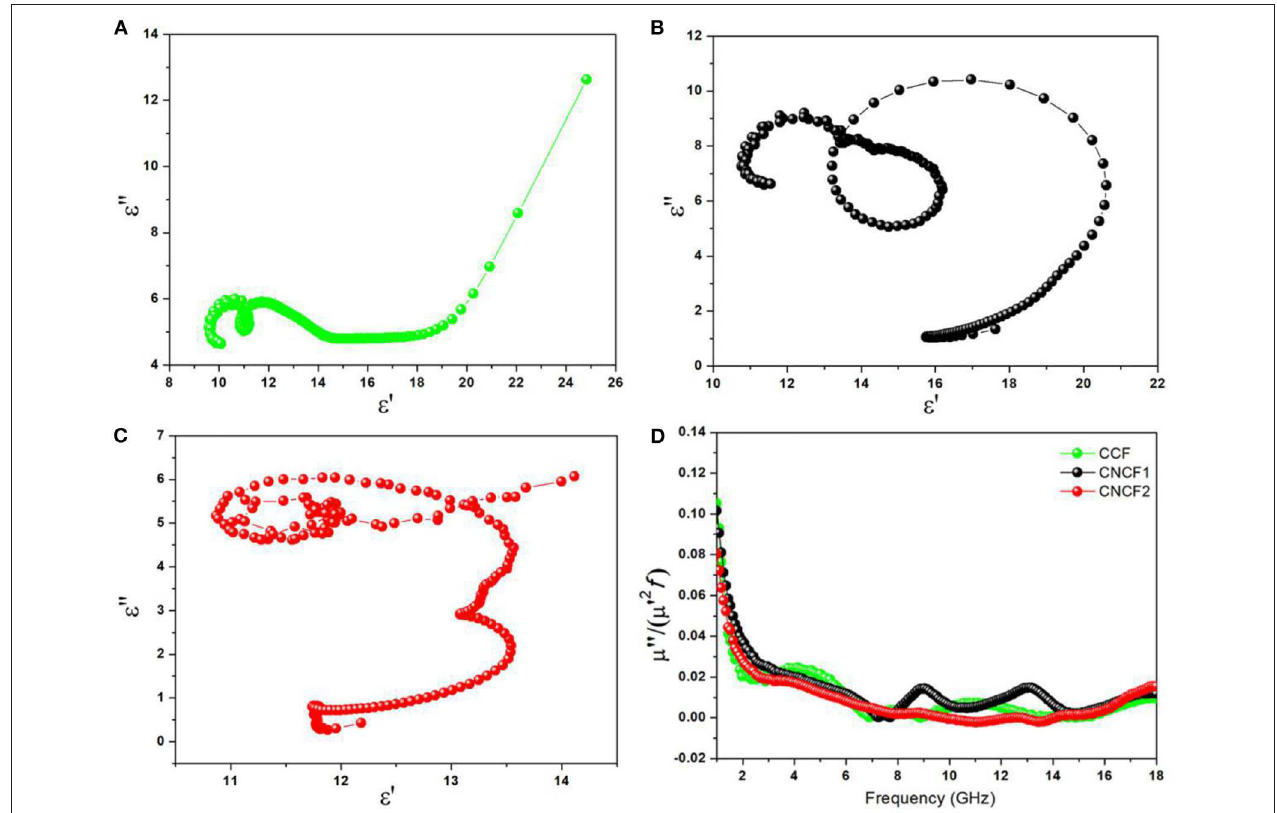
FIGURE 4 | Cole-Cole semicircles of CCF (A) , CNCF1 (B) , and CNCF2 (C) , and the µ ”( µ ’) − 2 f − 1 values (D) of composites at different frequencies.